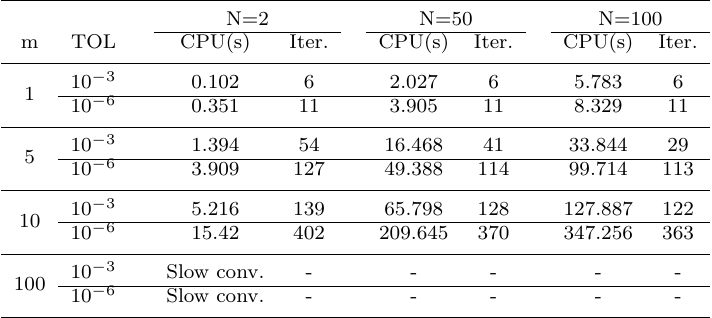
Table 2. Experiment for Algorithm